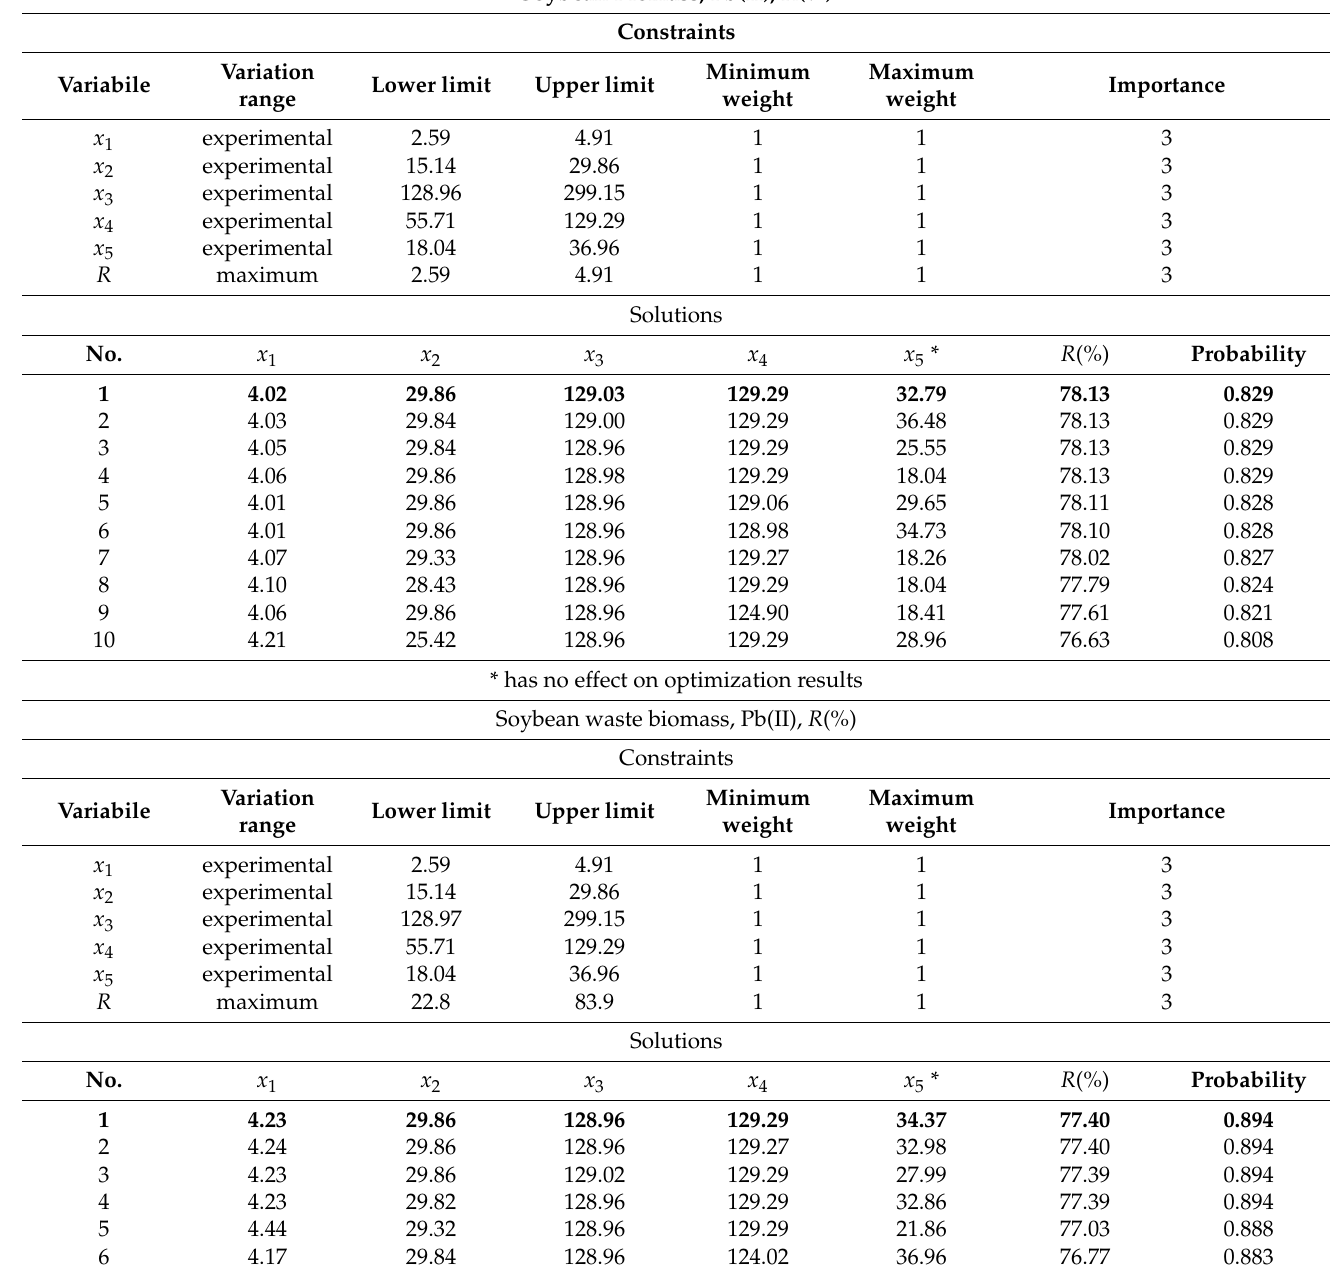
Table 10. Solutions for the operation in favorable conditions for reaching the maximum value of the biosorption efficiency ( R , %) on soybean biomass and soybean waste biomass. Soybean Biomass, Pb(II), R